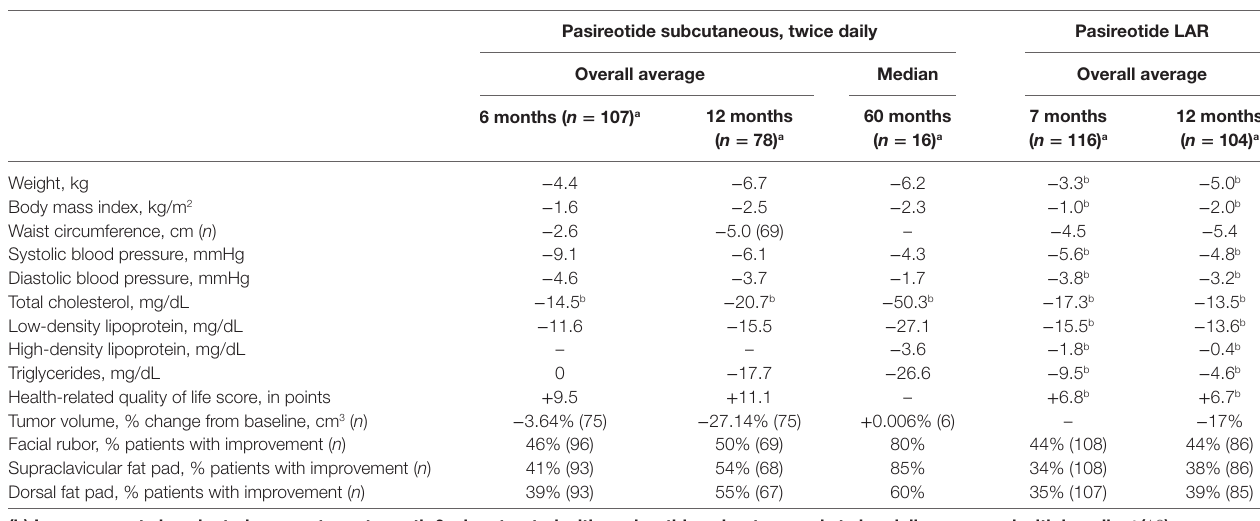
TABLe 1 | Clinical improvement in Cushing’s disease (CD) patients treated with pasireotide. (a) Overall changes in clinical signs and symptoms of CD when treated by pasireotide (16, 30, 31)